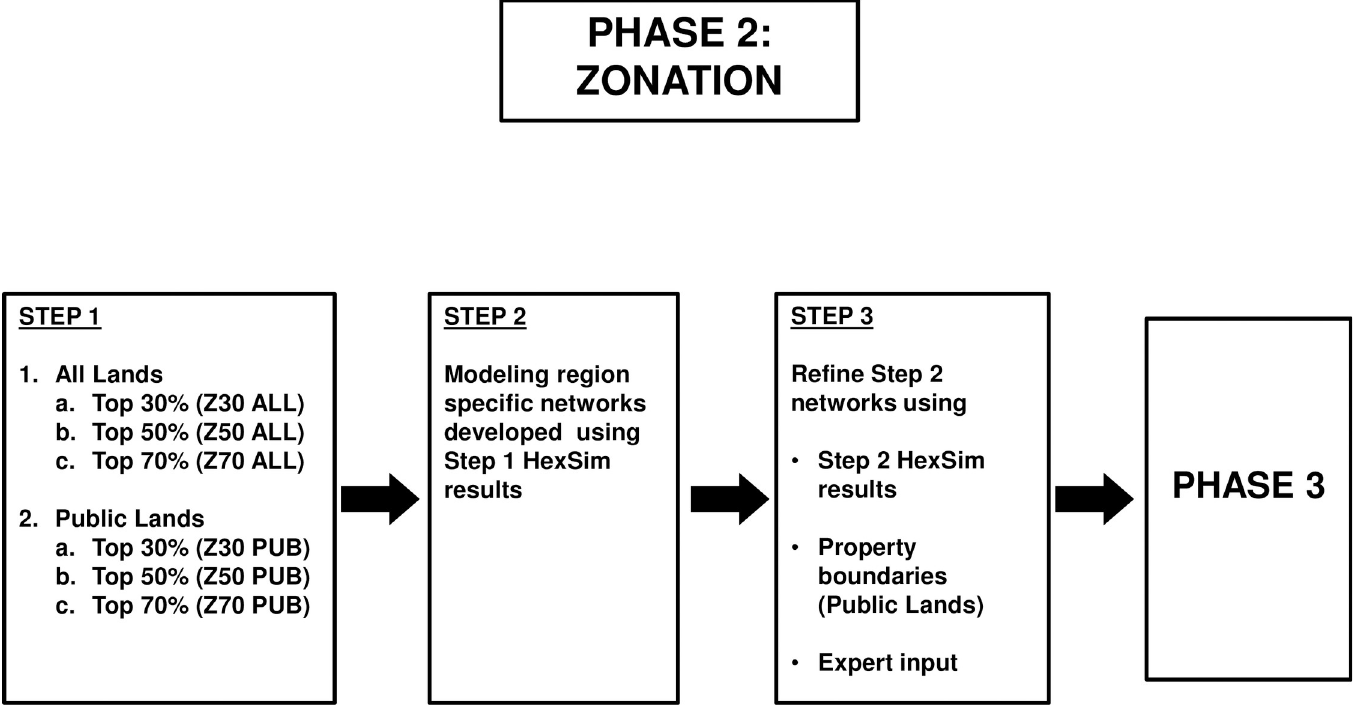
Fig 4. Flowchart of steps using Zonation to identify alternative candidate critical habitat networks for northern spotted owls.